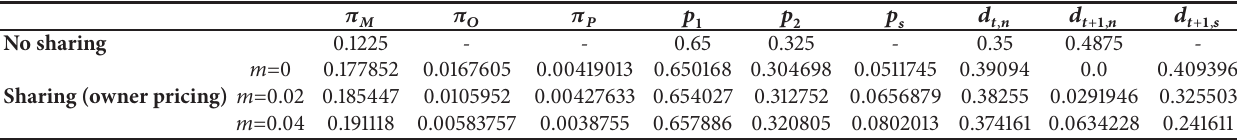
Table 4: Examples with a low-cost product (owner pricing).